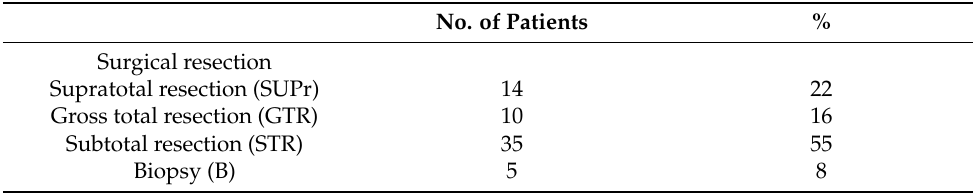
Table 2. Neuroradiological